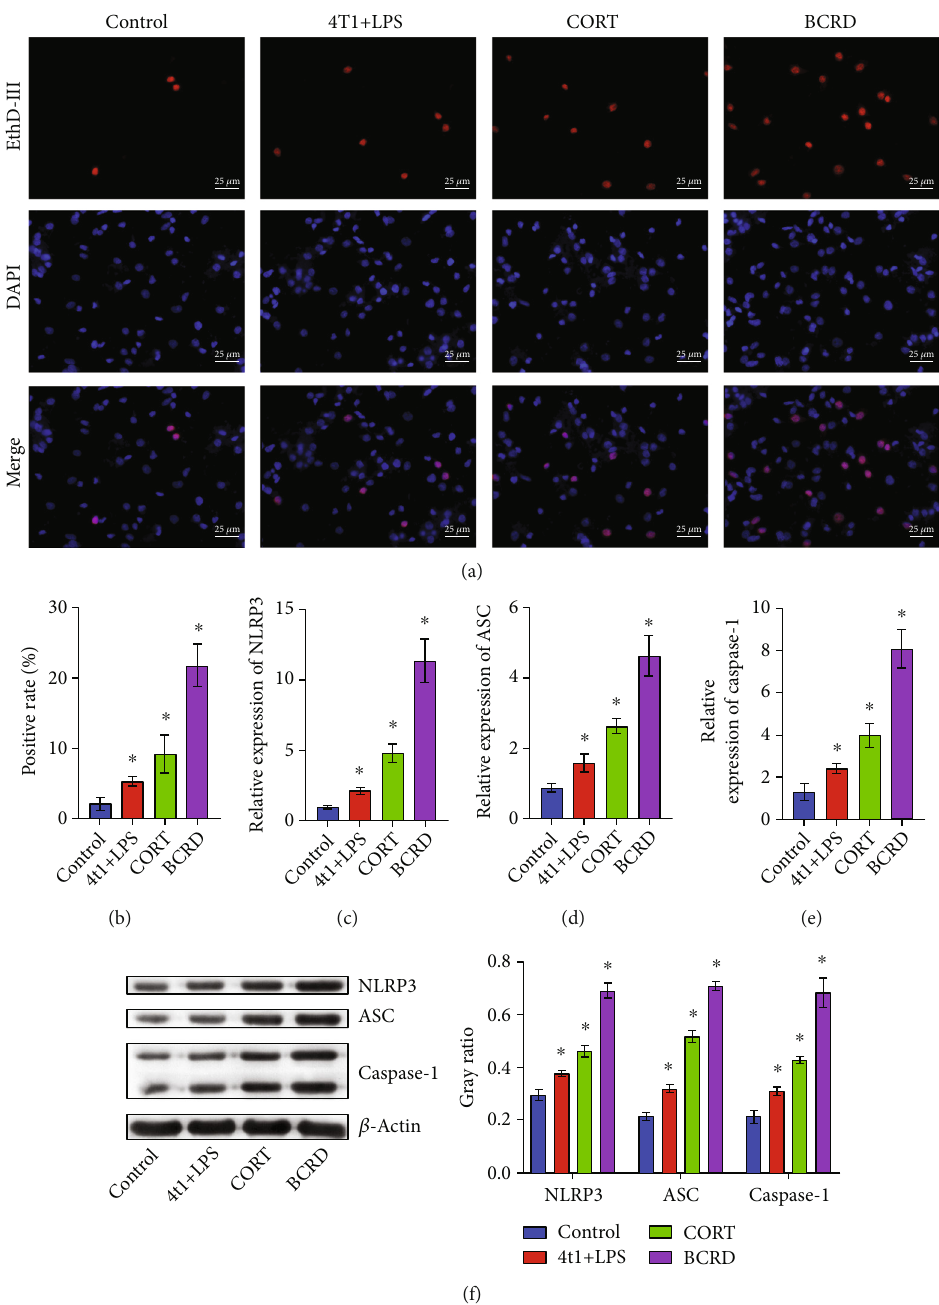
Figure 3: The occurrence of BCRD induced the pyroptosis of neurons. Neurons were treated with LPS+4T1, LPS+4T1+BCRD, or LPS+4T1 +CORD. (a, b) EthD-III staining was used to observe the membrane pores of neurons. (c – e) Caspase-1, ASC, and NLRP3 levels in neurons were assessed by RT-qPCR. (f) ASC, caspase-1, and NLRP3 levels in neurons were investigated by western blot. β -Actin was applied for quanti fi cation. ∗ p < 0 : 05 compared with